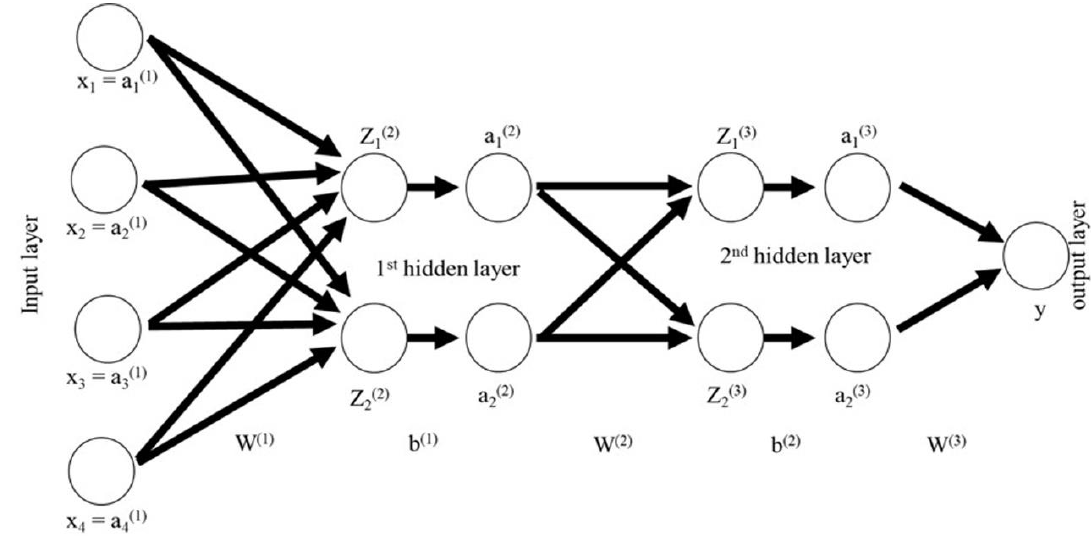
Figure 1. Architecture of back propagation neural network .